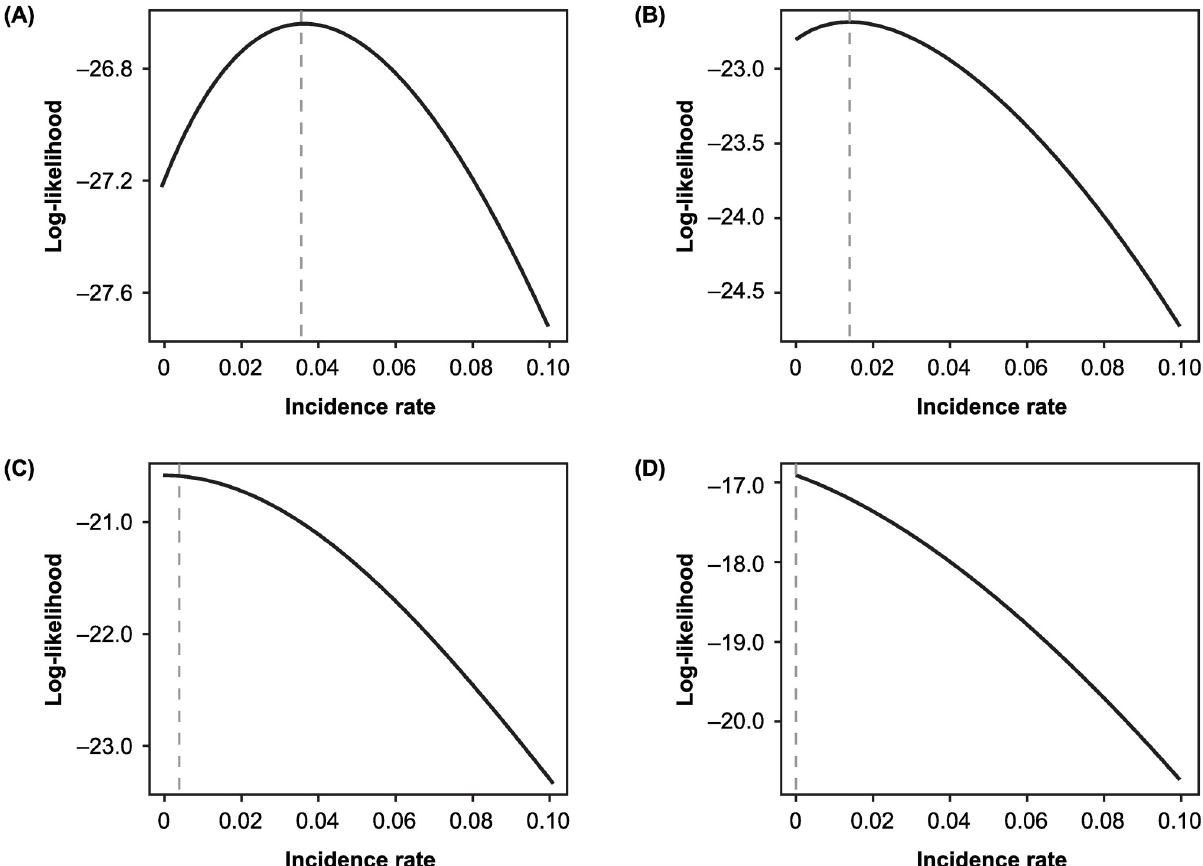
Fig 4. Behavior of the log-likelihood function. Shown is the log-likelihood function (the logarithm of the right side of Eq 6) as the positivity rate declines when p = 0.25, p = 0.05 and T = 100 tests are administered for positivity (A) 0.075, (B) 0.06, (C) 0.0525, and (D) FN FP